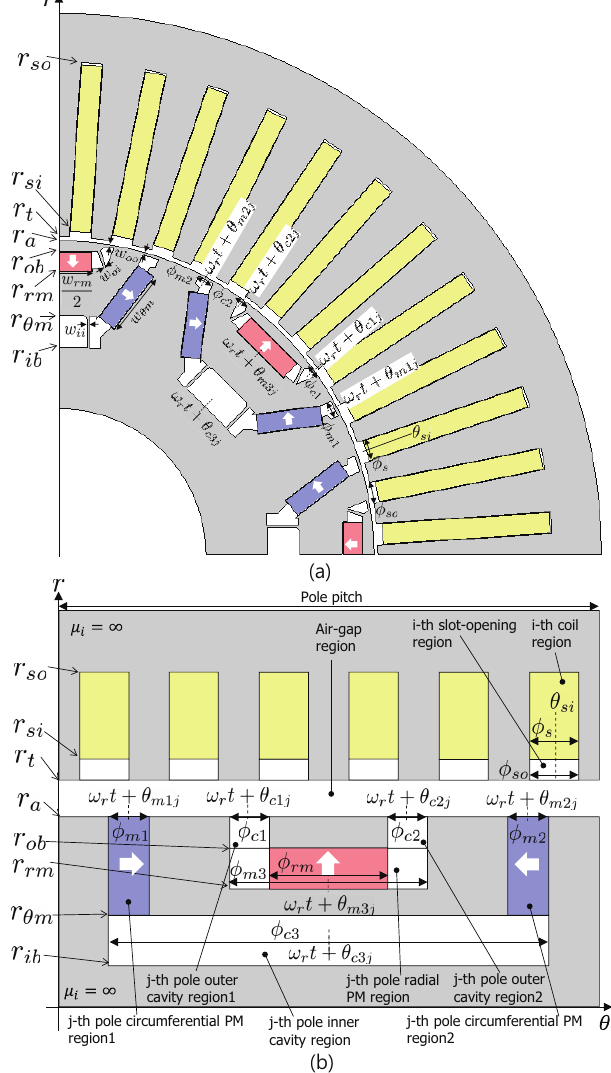
Figure 1. Machine configurations: ( a ) delta rotor with uniform slot stator and ( b ) equivalent model for subdomain